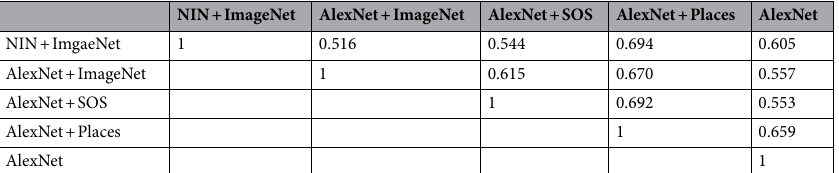
Table 3. Conditional probability P(A col is wrong|A row is wrong). Lower triangle contents of this table are ignored because of inclusion relationship of errors between